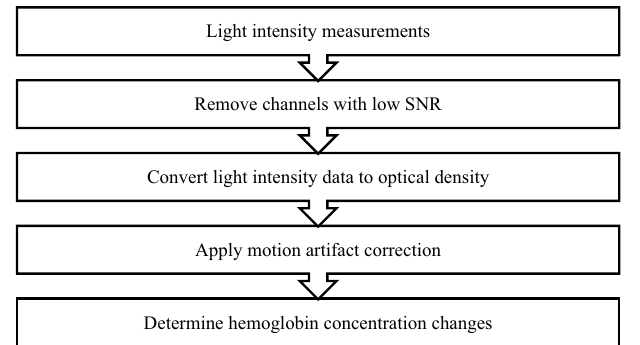
Figure 4. Adapted from the study by Novi et al., Workflow of the preprocessing steps of fNIRS data 63